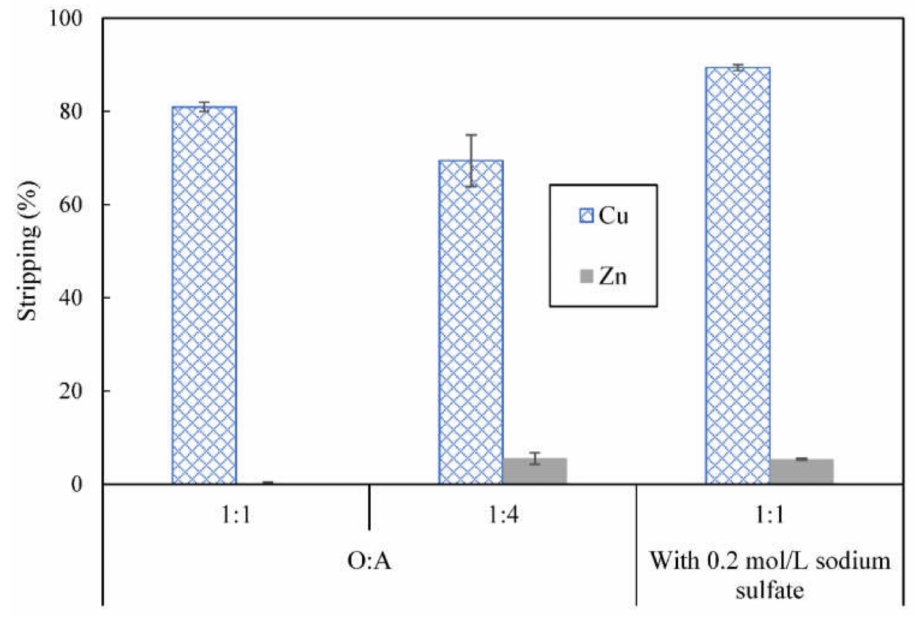
Figure 8. Effect of O:A ratio and addition of sodium sulfate on stripping of metal ions from loaded organic phase; all stripping solutions contained 2 mol/L acetic acid, concentration of D2EHPA used was 4% ( v / v ), stripping time = 5